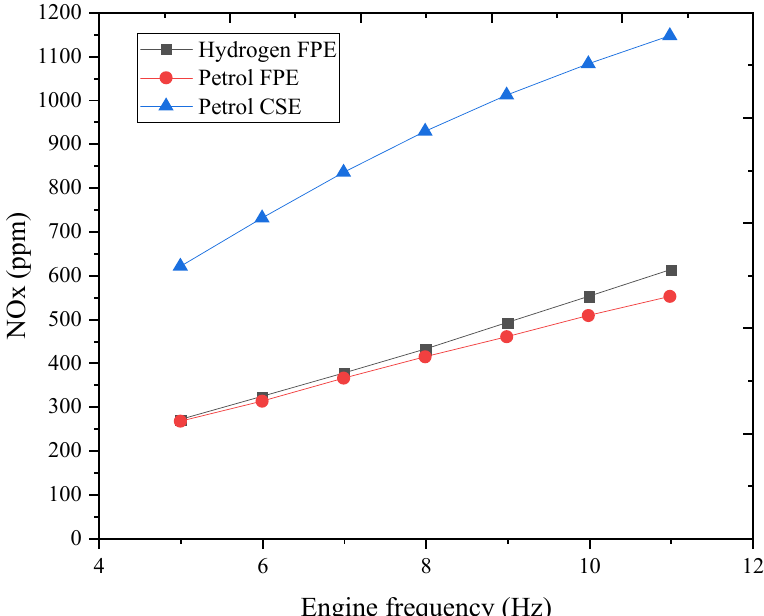
Figure 13. NOx emission comparison between three models.